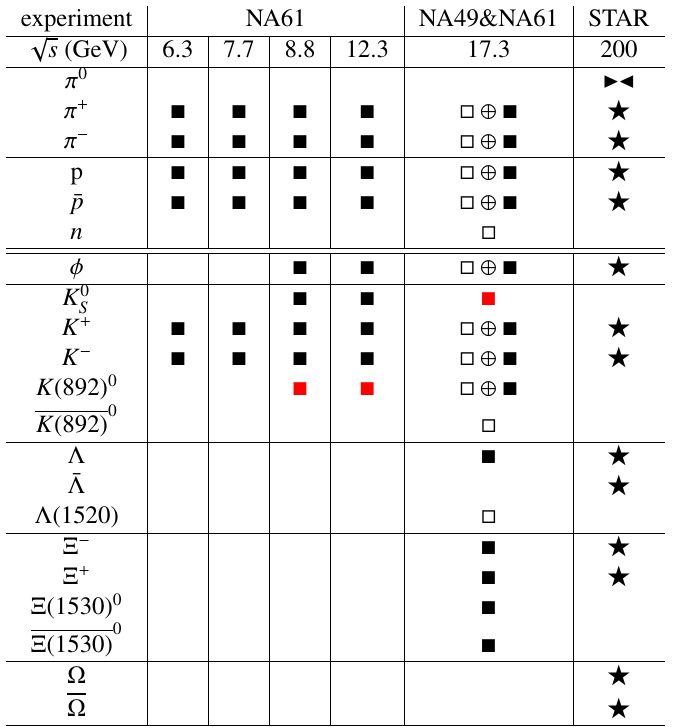
= 1 baryons, (vi) = 2 baryons, (vii) = 3 baryons. The S S S | | | | | | ■ = merged NA49 and NA61 / SHINE ([3] ⊕